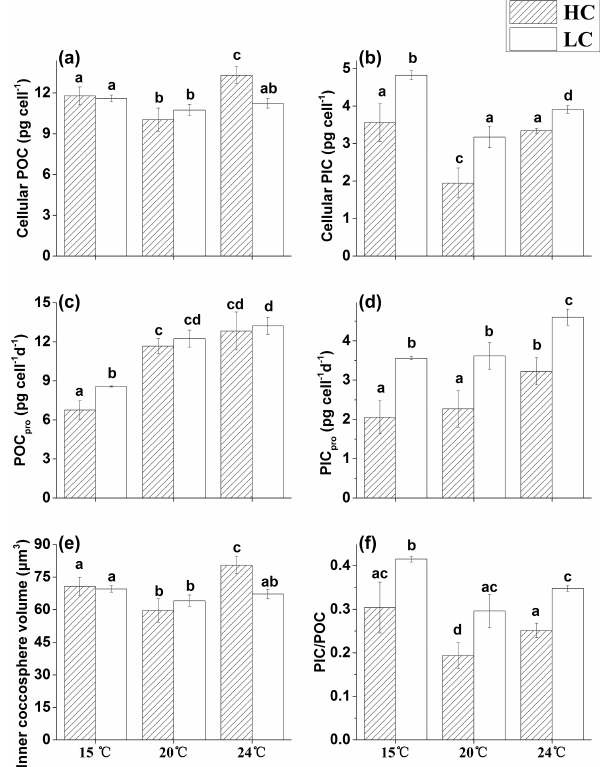
Figure 3. The cellular POC (a) , cellular PIC (b) , POC produc- tion rate (c) , PIC production rate (d) , inner coccosphere volume (e) and PIC / POC ratio (f) of E. huxleyi grown in 400µatm (LC) and 1000µatm (HC) CO 2 concentrations at 15, 20 and 24 ◦ C, respec- tively. The different letters above the bars indicate significant differ- ences among the treatments ( p < 0 . 05). The values are the means, and the error bars are standard deviations for triplicate cultures for each treatment.